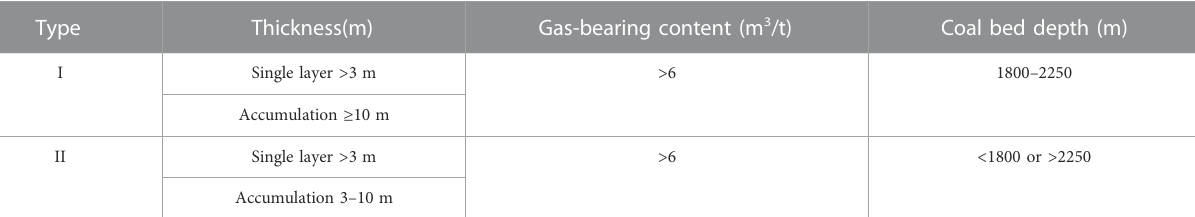
TABLE 1 Evaluation parameter table of the favorable zone of coalbed methane in eastern